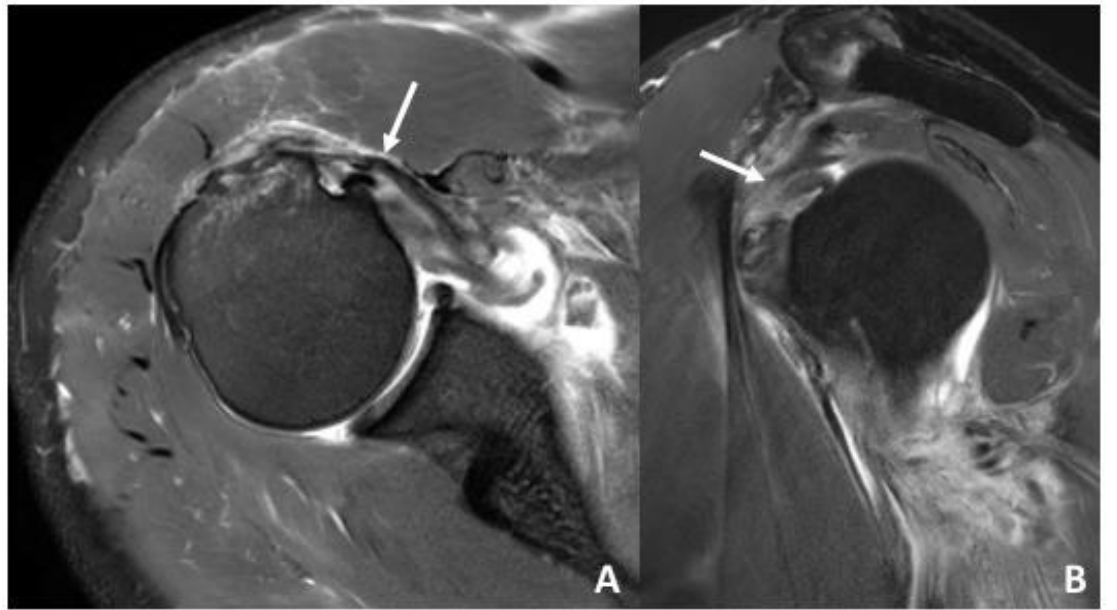
Figure 1. Sagittal IM-weighted TSE sequence with spectral fat saturation. ( A ) Intact biceps pulley in a 26-year-old patient after anterior shoulder dislocation with normal discrimination of the sGHL (white arrow) and CHL. ( B ) Insufficient biceps pulley on a 32-year-old patient after shoulder dislo- cation due to a tear of the sGHL (white arrow). Caudal displacement of the LHBT is seen at the middle of the rotator interval. Note the joint effusion in both patients which causes an arthrographic effect and helps with the discrimination of anatomical structures.